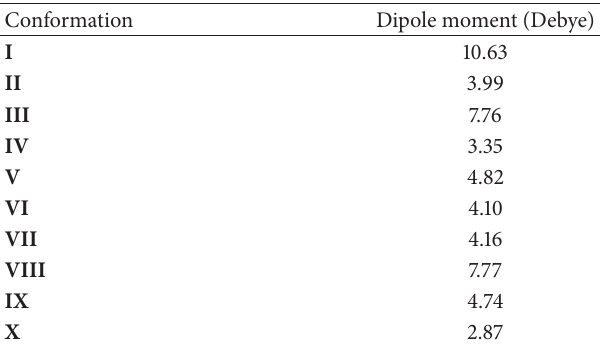
Table 2: Conformation versus the calculated dipole moment